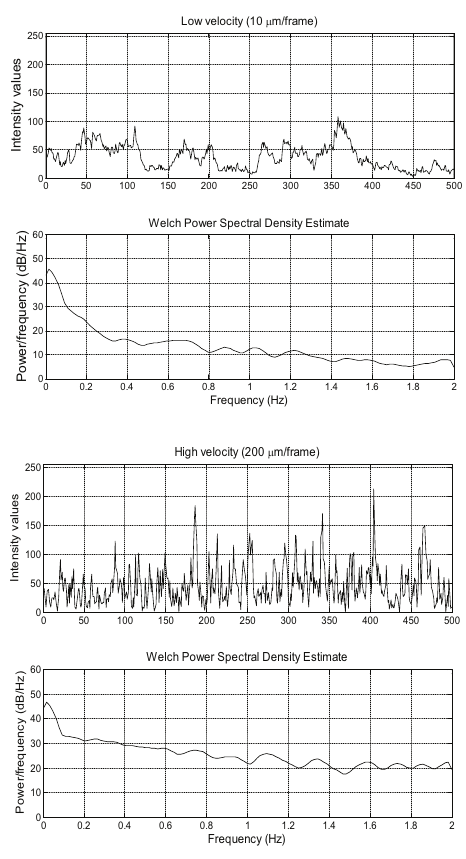
Fig. 1. Intensity series of simulated speckle patterns at low and high velocities For the case of low frequency bands, a prior subtraction of the mean value of the signal ( (cid:162) X (cid:178) )